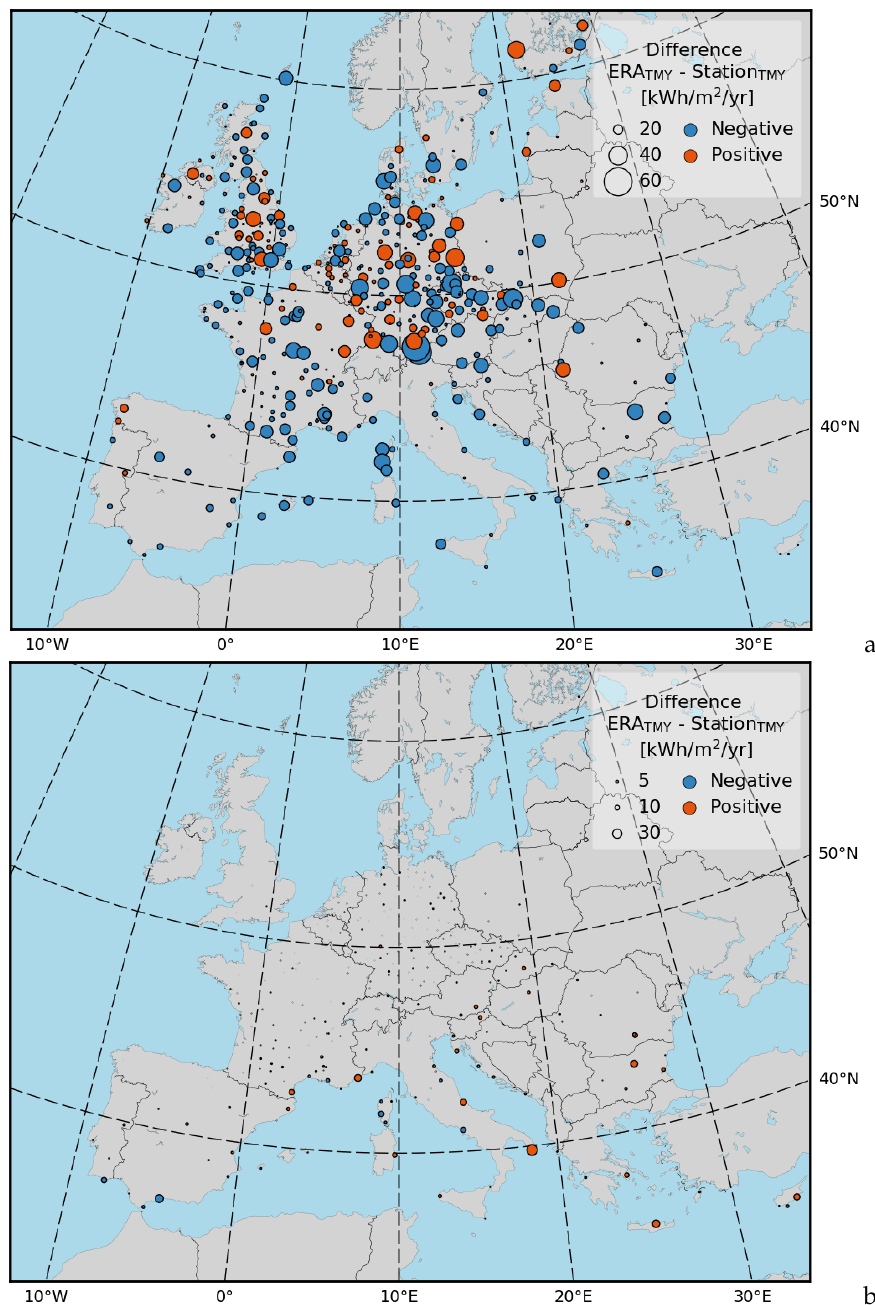
Figure 6. Difference in EnergyPlus calculation for the single family house when using the ERA-based TMY instead of the station-based TMY data. ( a ) heating energy consumption; ( b ) cooling energy consumption. Values are shown as kWh/m 2 difference, with the size of the marker indicating the magnitude of the